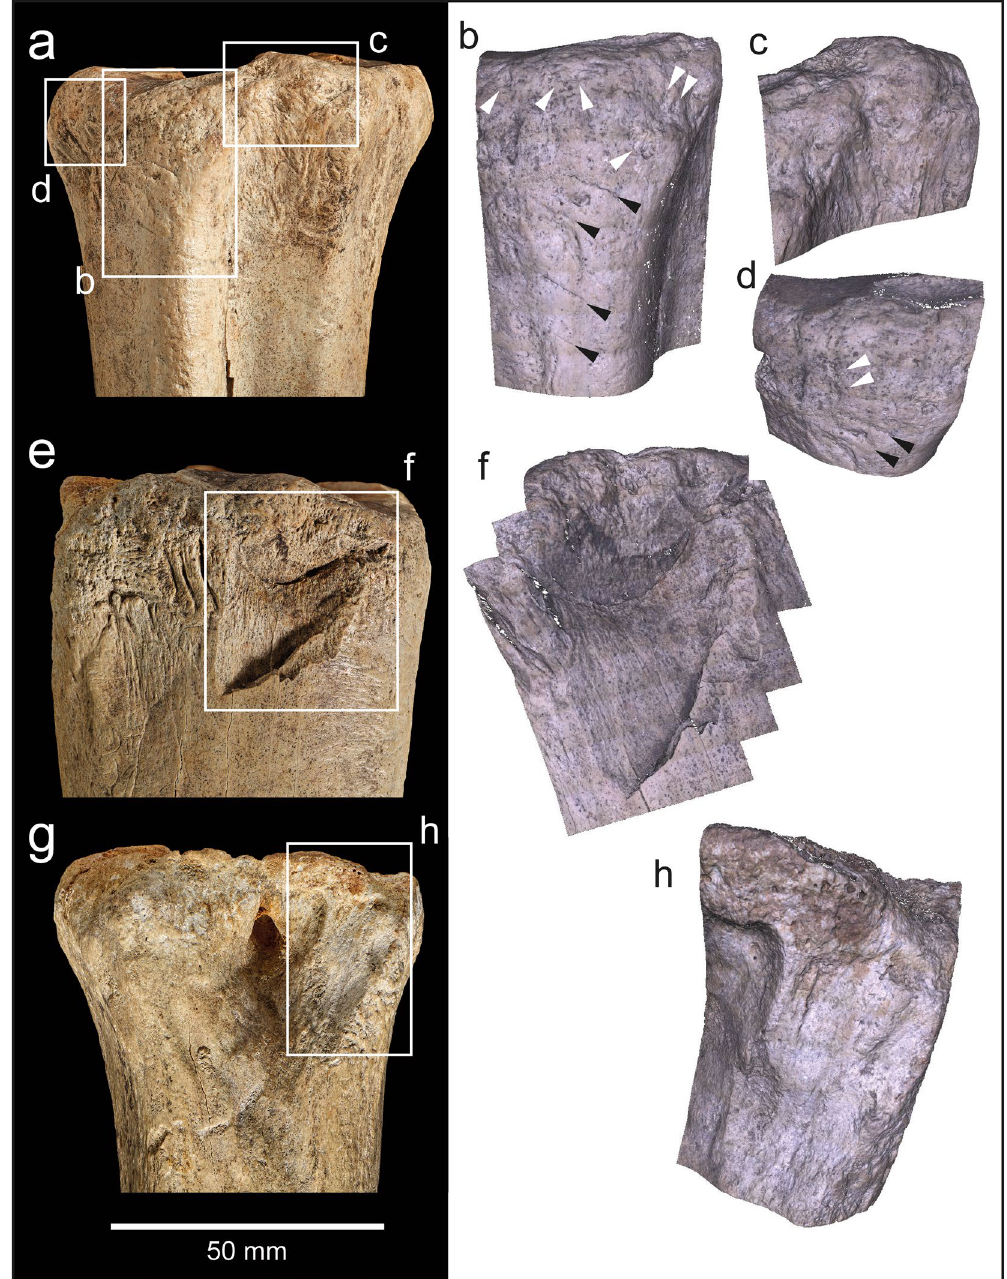
Figure 4. Bison metatarsal NHMUK PV M 15260. Photographs and Alicona images of the battering and flaking of the proximal end of the metatarsal (note rounding along the edge of the articular surface). ( a – d ) battering damage on the dorsal surface (black arrows indicate knapping scores; white arrows point to knapping pits), ( e – h ) flaking on the medial and plantar